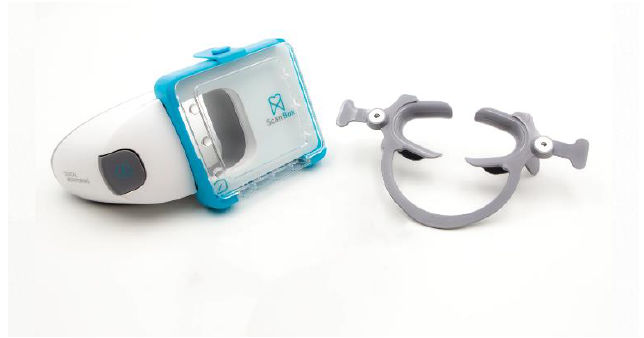
Figure 1. Dental monitoring (DM) ScanBox© and cheek retractor.